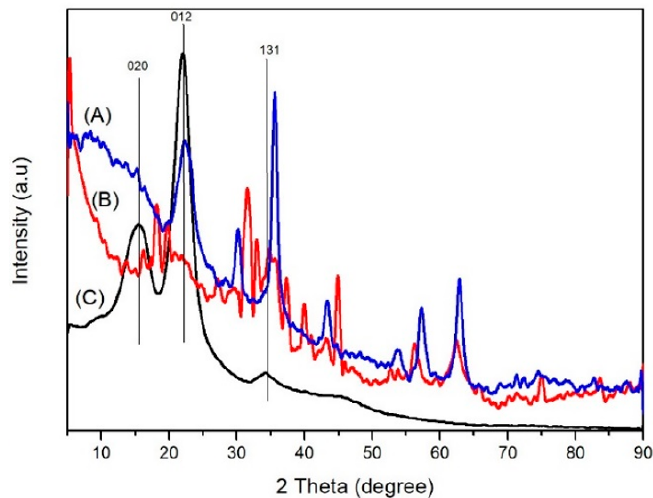
Figure 3. Diffractogram from XRD analysis of ( A ) of magnetic jabon wood treated in-situ with NaOH precursor (blue line); ( B ) magnetic jabon wood with NH 4 OH precursor (red line), and ( C ) untreated jabon wood (black line).